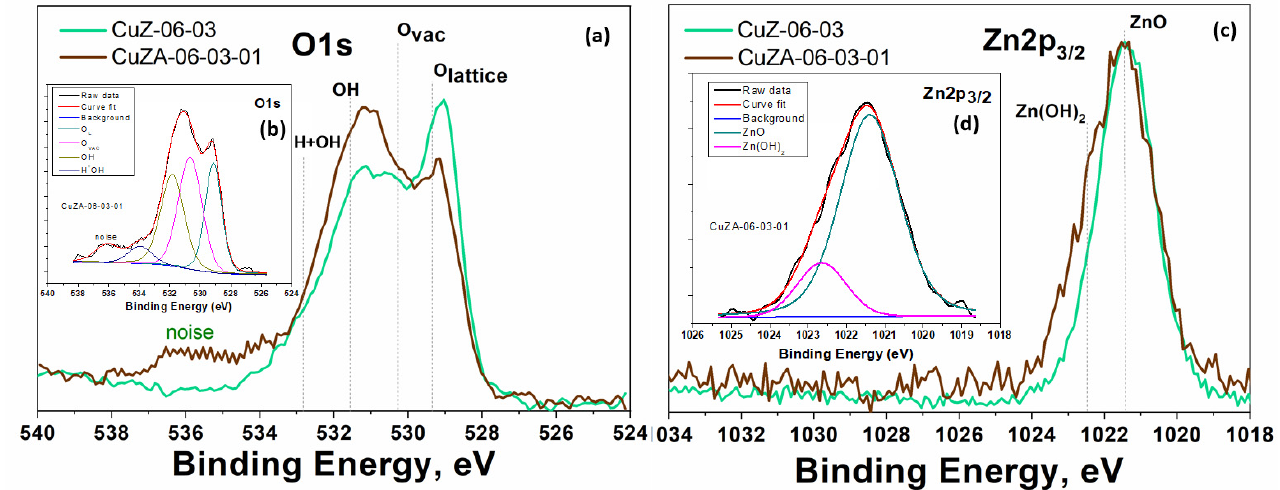
Figure 8. XPS spectra of CuZ-06-03 and CuZA-06-03-01 catalysts: ( a ) High-resolution O1s XPS spectra, ( b ) inset with deconvolution peaks of the O1s spectra, ( c ) high resolution Zn2p3/2 XPS spectra, and ( d ) inset with deconvolution peaks of the Zn2p3/2.